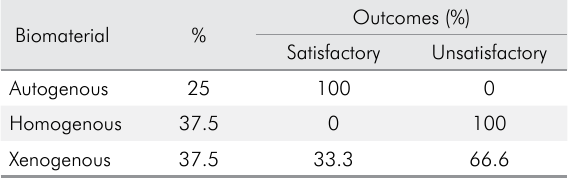
Table 3. Overview of Group A